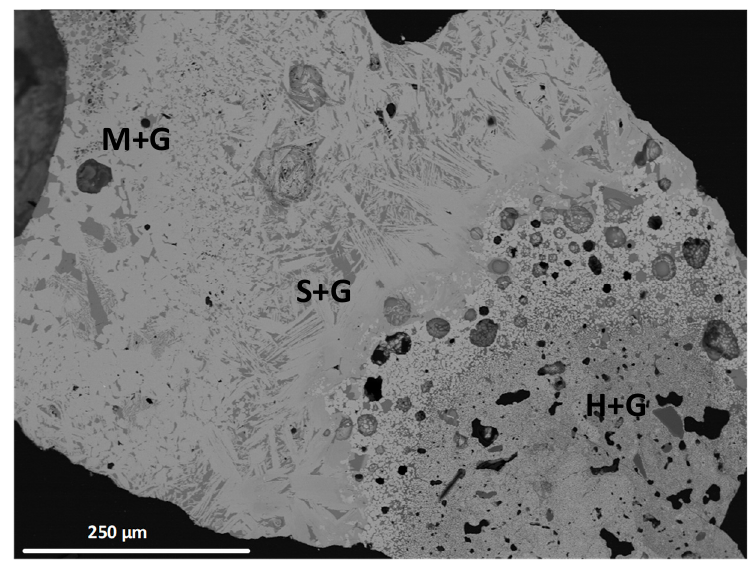
Figure 13. Examples of the heterogeneous structure of the sinter materials showing diffuse transition between macrostructures (G—Glass, H—Hematite, M—Magnetite, S—SFCA) (BSE image).